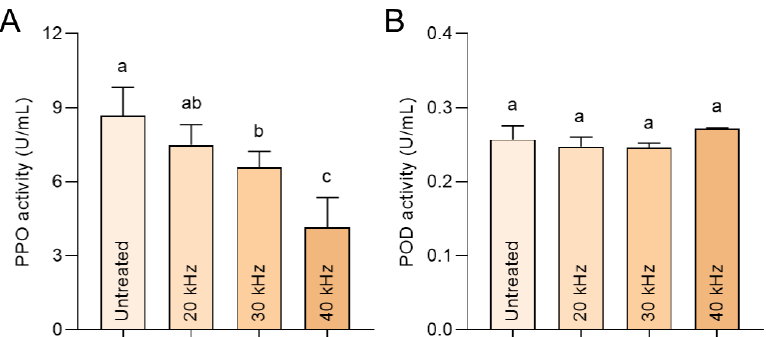
Figure 5. Polyphenol oxidase and peroxidase activity. ( A ) Polyphenol oxidase (PPO) and peroxidase (POD). ( B ) Activity of Sanhua plum wine after three-month aging. Different letters indicate a significant difference between the groups.